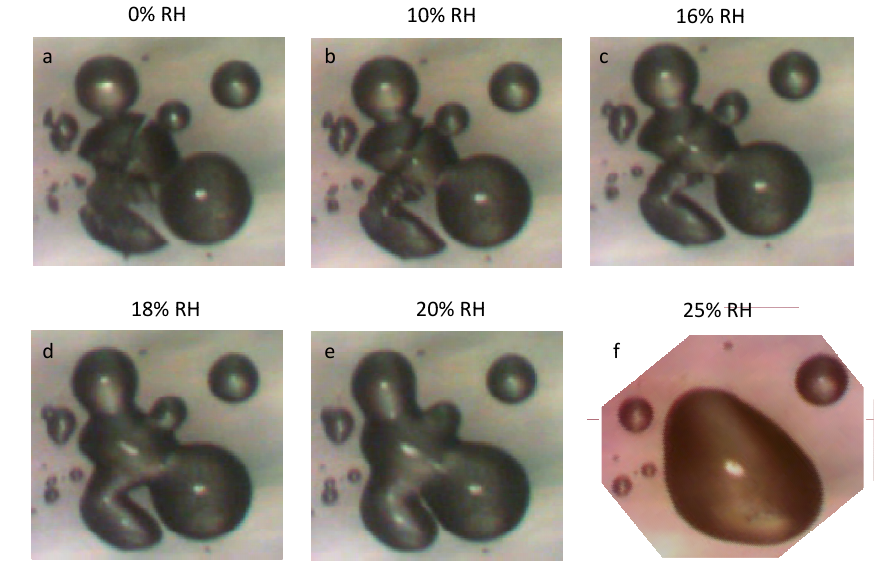
Fig. 6. Sequence of images of a cracked droplet gradually taking up water and flowing to reform a single droplet on increasing RH. (f) was taken with a different camera, hence the difference in orientation. The width of the microscope images is 160µm. In these experiments the RH was ramped up to 18% over the course of 30 min. It was then stepped up to 20% and held there for about 30 min and then stepped up to 25% where it was again held for about 20 min.